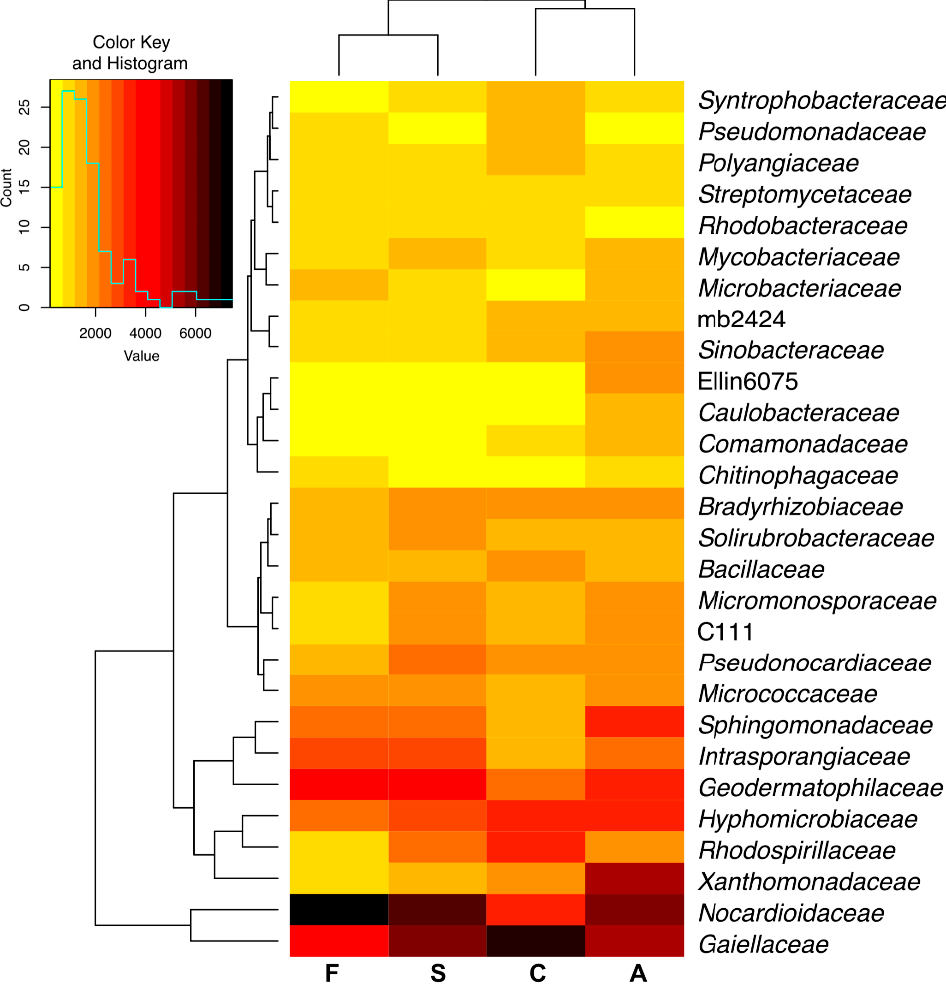
Figure 8. Heat map and associations of the number of bacterial families in soil with a difference between proportions ≥ 1%. C—uncontaminated soil; A—soil contaminated with BPA; F—soil contaminated with BPF; S—soil contaminated with BPS.